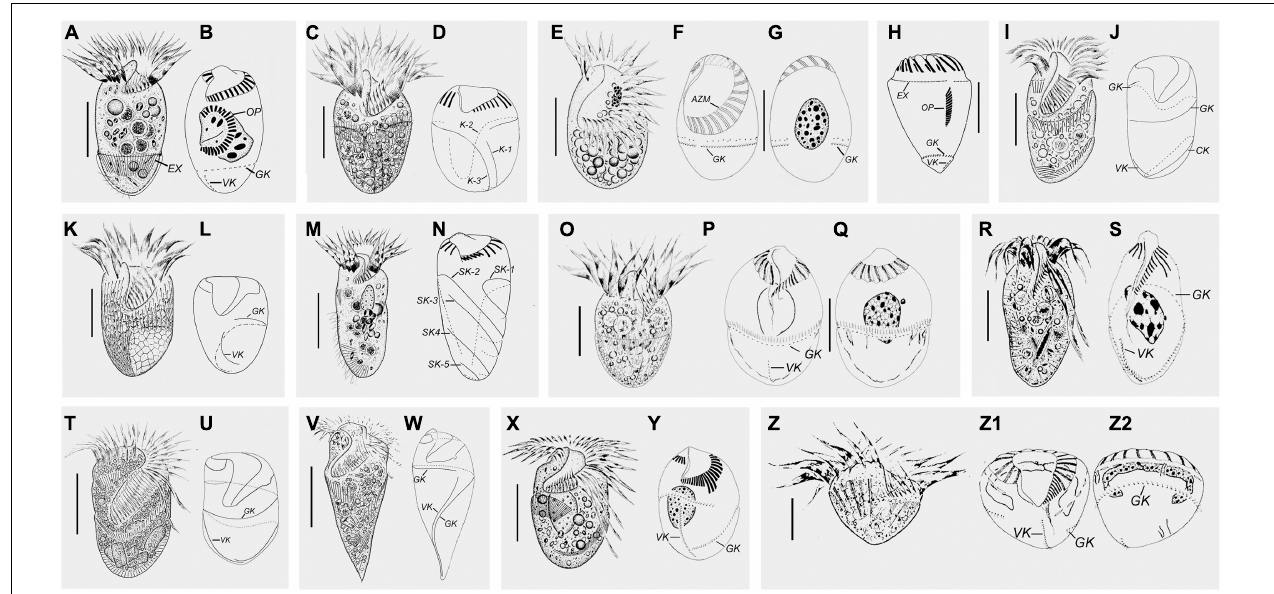
FIGURE 2 | Schematic diagrams from specimens in vivo and after protargol staining of representative species of each strombidiid genus. (A,B) Opisthostrombidium montagnesi (after Xu et al., 2006; Agatha, 2011). (C,D) Apostrombidium parakielum (after Song W. et al., 2013). (E–G) Williophrya maedai (after Liu et al., 2011). (H) Foissneridium constrictum (after Agatha, 2011). (I,J) Antestrombidium agathae (after Liu et al., 2015b). (K,L) Sinistrostrombidium cupiformum (after Liu et al., 2015b). (M,N) Varistrombidium kielum (after Xu et al., 2011). (O–Q) Strombidium sulcatum (after Song et al., 2000). (R,S) Omegastrombidium elegans (after Song et al., 2000). (T,U) Spirostrombidium faurefremieti (after Wang et al., 2018). (V,W) Parallelostrombidium jankowskii (after Song et al., 2018). (X,Y) Novistrombidium (Propecingulum) sinicum (after Liu et al., 2009). (Z–Z2) Novistrombidium (Novistrombidium) testaceum (after Song and Bradbury, 1998). Scale bars = 20 µ